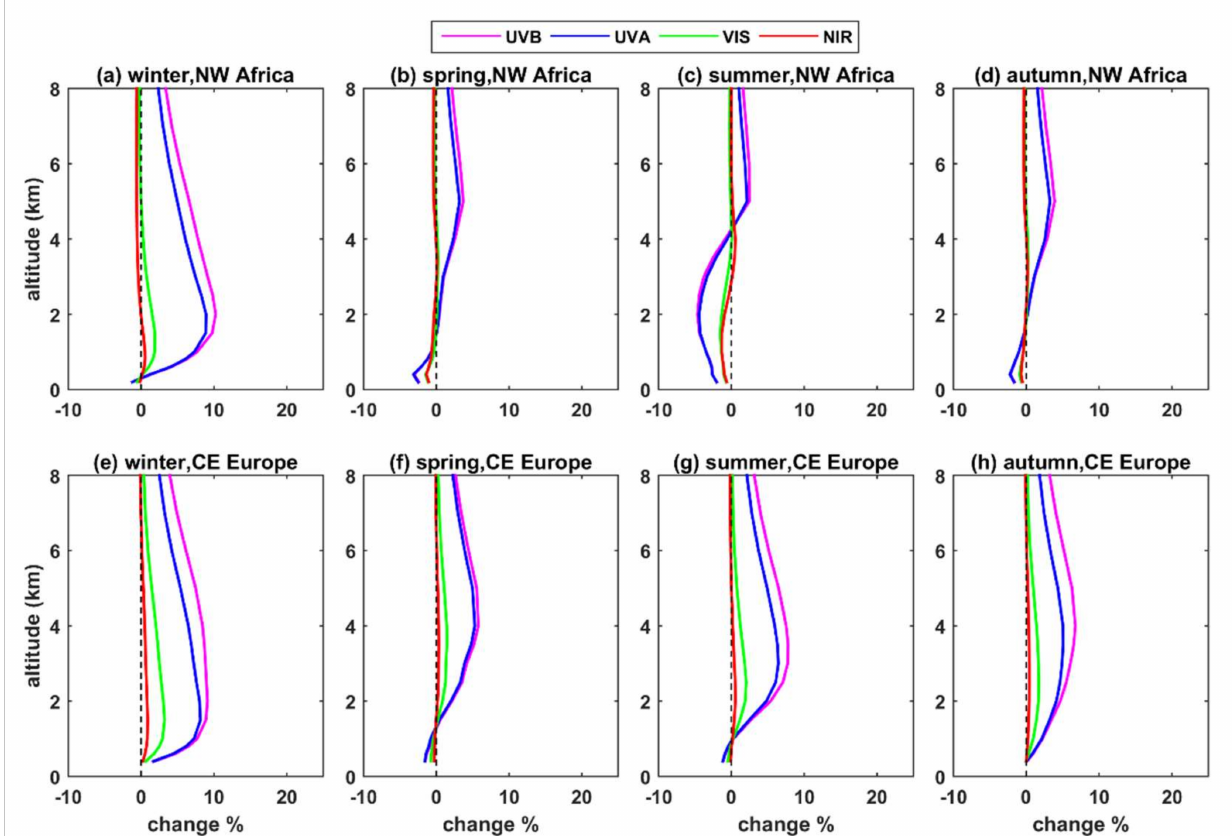
Figure 9. Change (in %) in the AF in the first 8 km of the atmosphere due to the use of the LIVAS profiles instead of the default libRadtran profile. Results are for SZA = 60 ◦ . The corresponding graphs for 30 ◦ and 80 ◦ are provided in Appendix